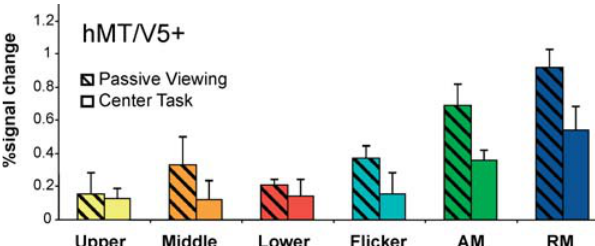
Figure 5. Attentional Modulation of Activity in hMT/V5 þ in Experiment 2 Responses to the different conditions in experiment 2 for the region hMT/V5 þ are shown. The bars designate percentage signal change of the peak response relative to baseline (see Materials and Methods). The hatched bars are activations from runs with passive viewing only, and the solid bars are from runs with center task. The static conditions— upper, middle, lower, and flicker—induced only low activation in hMT/ V5 þ . In contrast, the response to apparent motion and real motion was higher, corresponding with the motion sensitivity of hMT/V5 þ . The attentional modulation of the responses was very strong. Under all conditions, the activity was smaller during runs with center task than during runs with passive viewing. Error bars correspond to standard errors of the